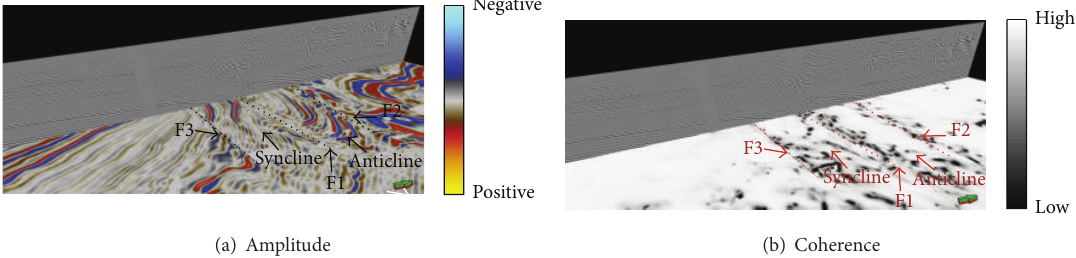
Figure 11: (a) Amplitude and (b) coherence attributes showing interpreted faults (F1, F2, and F3) and folds. Note that there are no significant coherence anomalies for folds.